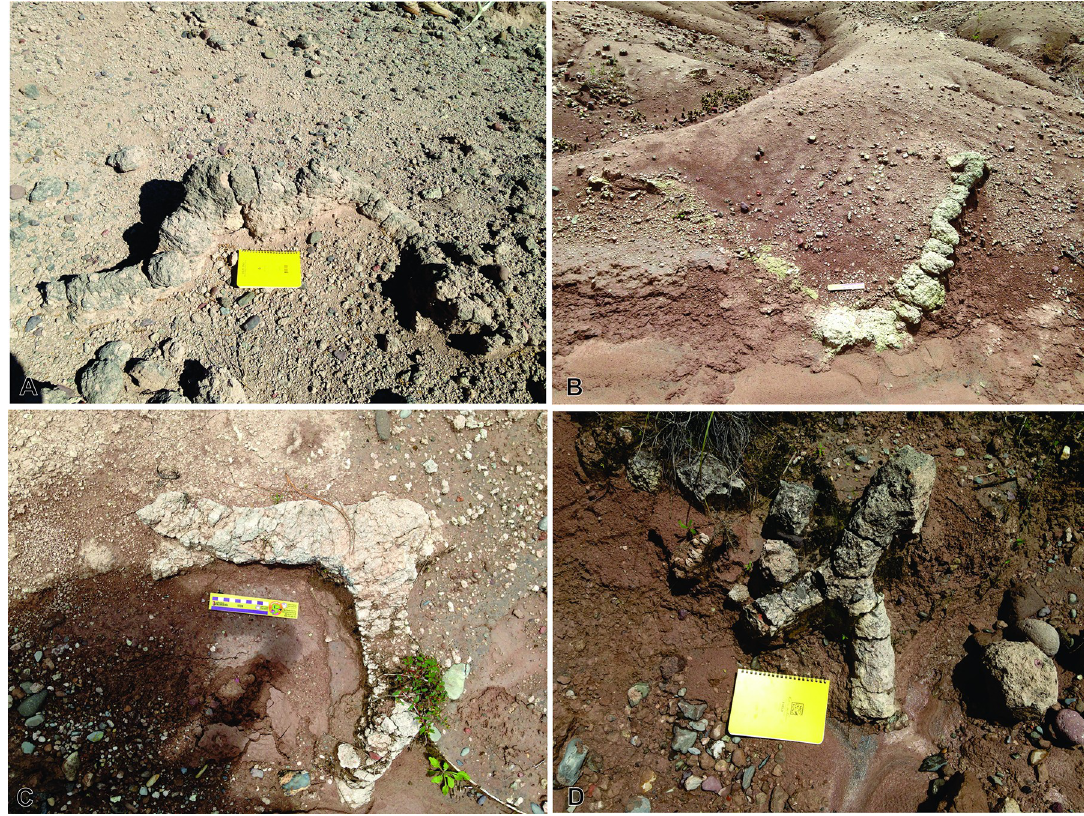
Fig 9. Burrows showing the characteristic arrangement in packets of the sediment fillings, indicating of active burrowing. (A) Secondary chamber and segments of an almost straight tunnel. Length of the scale = 18 cm. (b) Isolated segment of sinuous tunnel and remains of a secondary chamber. Length of the scale = 17cm. (c) Remains of a horizontal tunnel, originally bifurcated, (D) Sub- horizontal segment of a tunnel, bifurcated. All the specimens are in situ from “middle beds” strata.